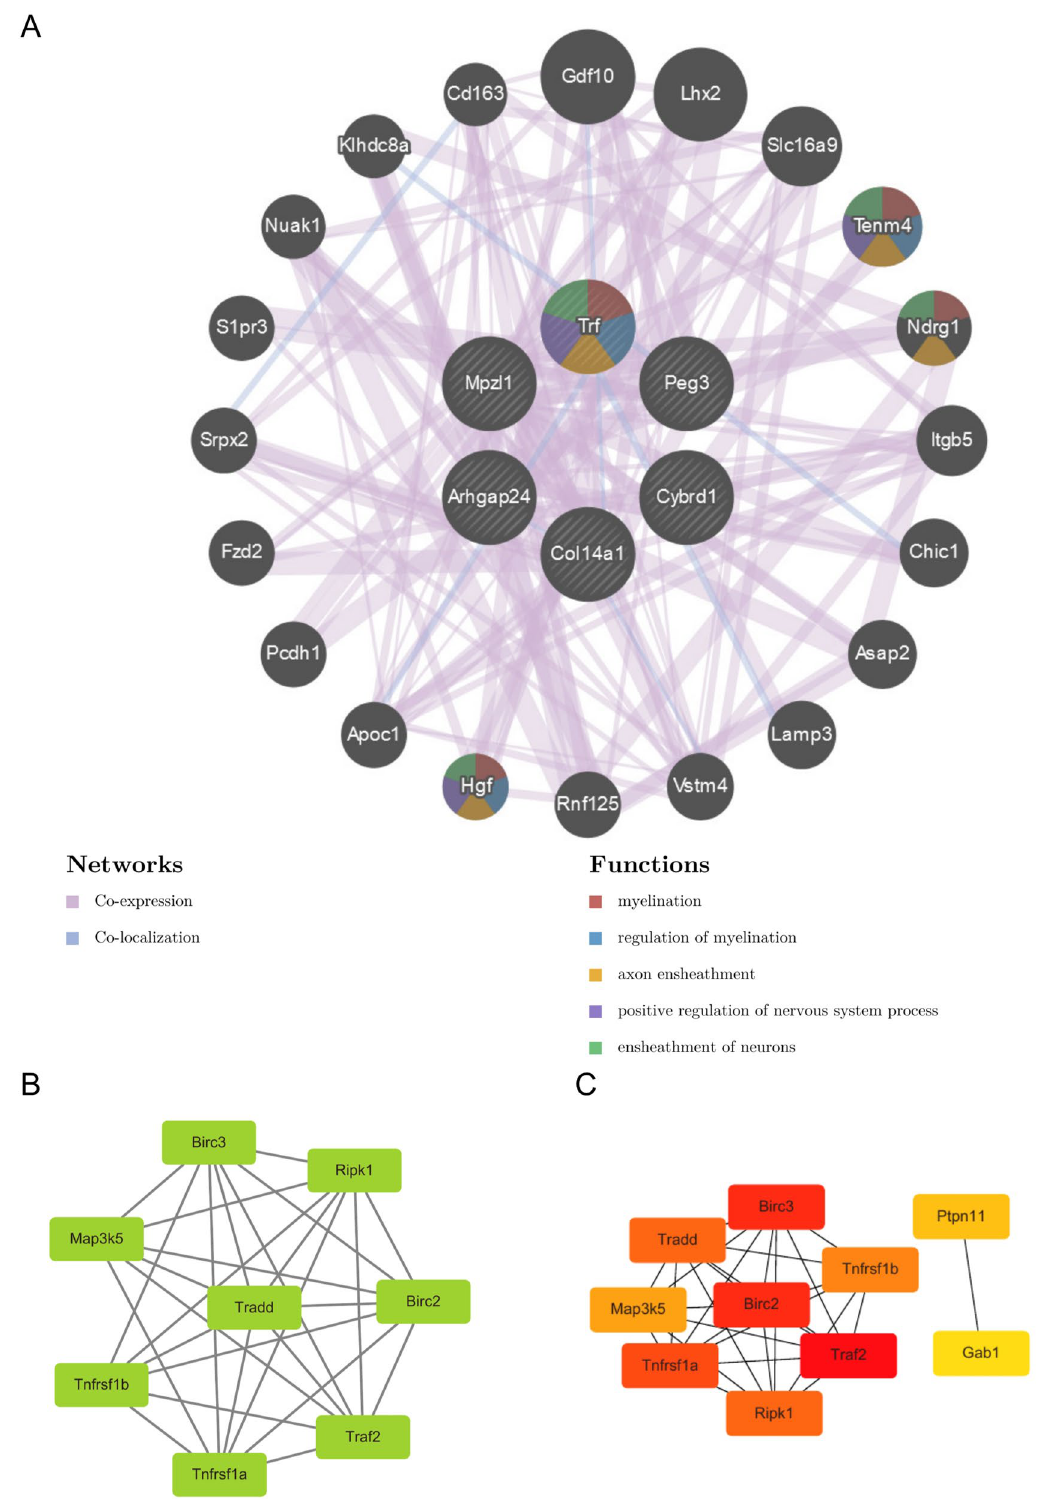
Figure 4. PPI network: ( A ) Common gene PPI network. ( B ) Key protein expression module ( C ) PPI networks encoded by key gene